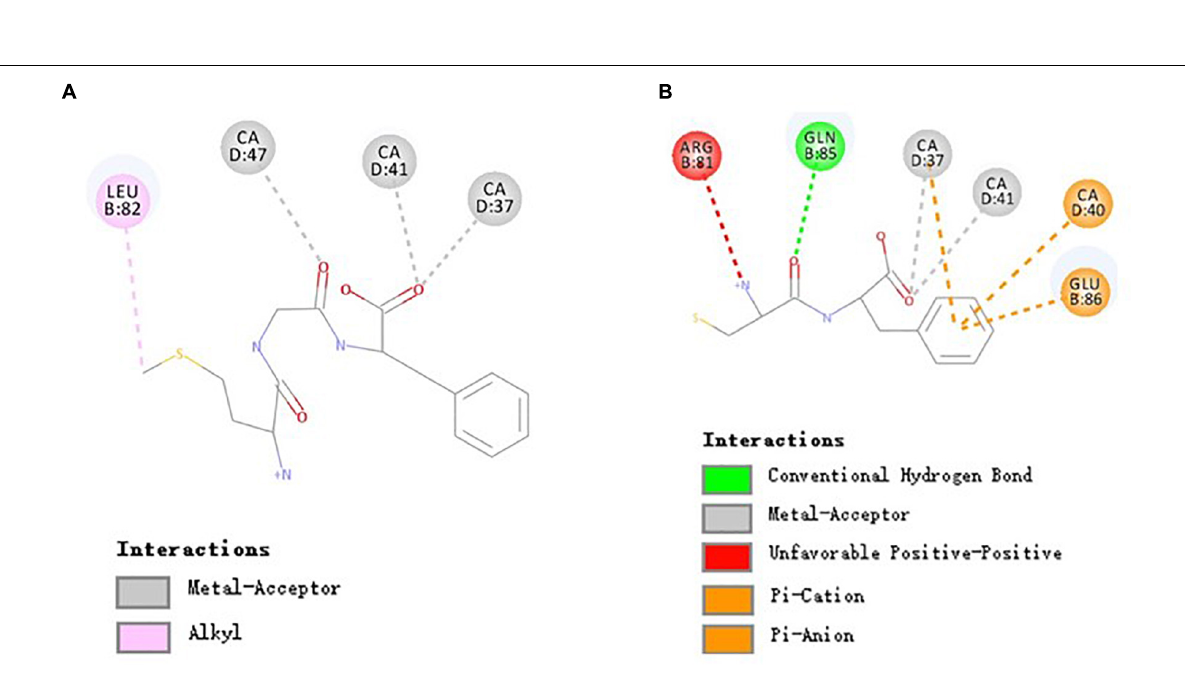
Frontiers in Nutrition |